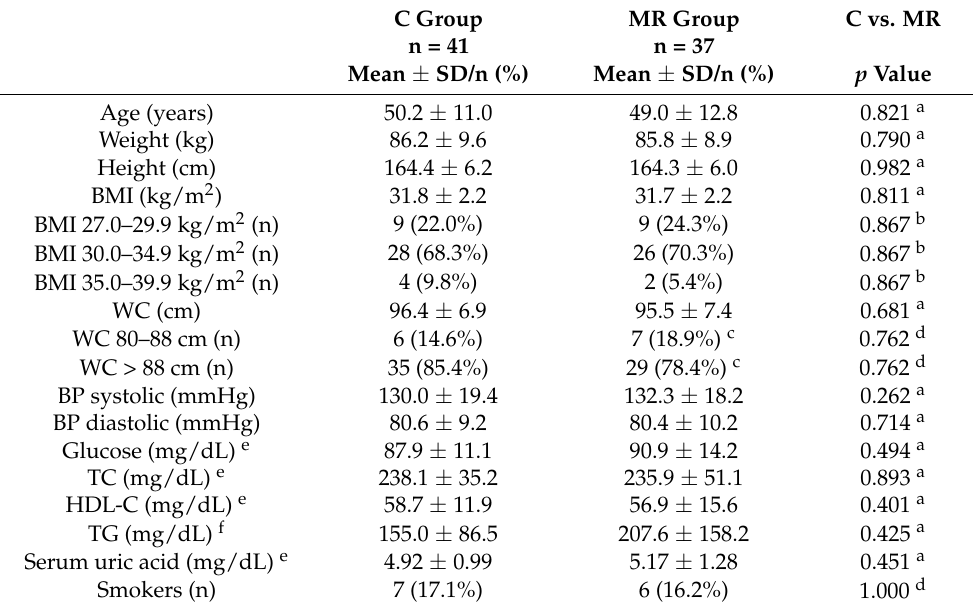
Table 1. Baseline characteristics of overweight women.